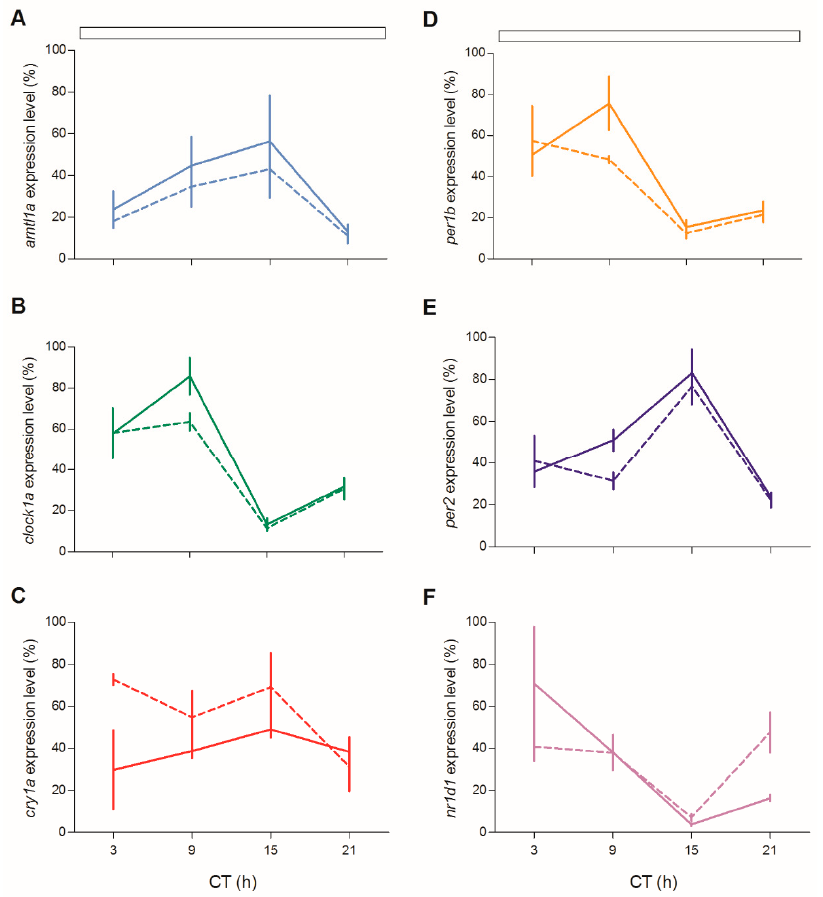
Figure 12. Circadian expression levels of clock genes in zebrafish juvenile. qPCR analysis of clock ( A , B , D , F ) and light-regulated clock ( C , E ) gene expression in zebrafish juvenile at the third day of starvation after feeding entrainment. White bars represent LL. For more details see Figure 4.